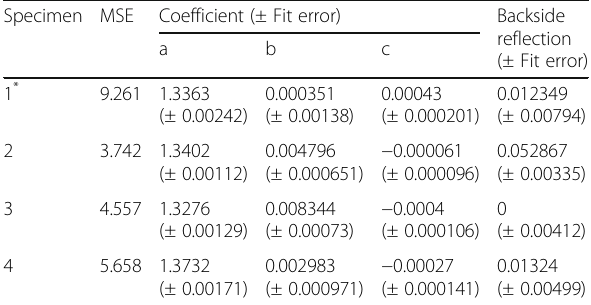
Table 3 Coefficients in the ellipsometric analysis for Pegea confoederata tunic Specimen